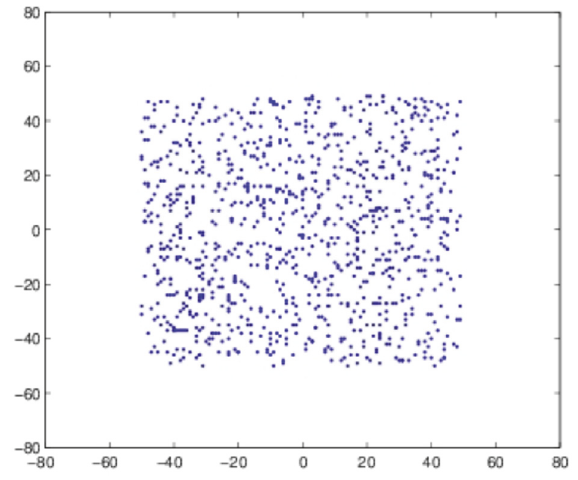
Figure 1: It shows a set of independent signals with non-Gaussian PDF [9].